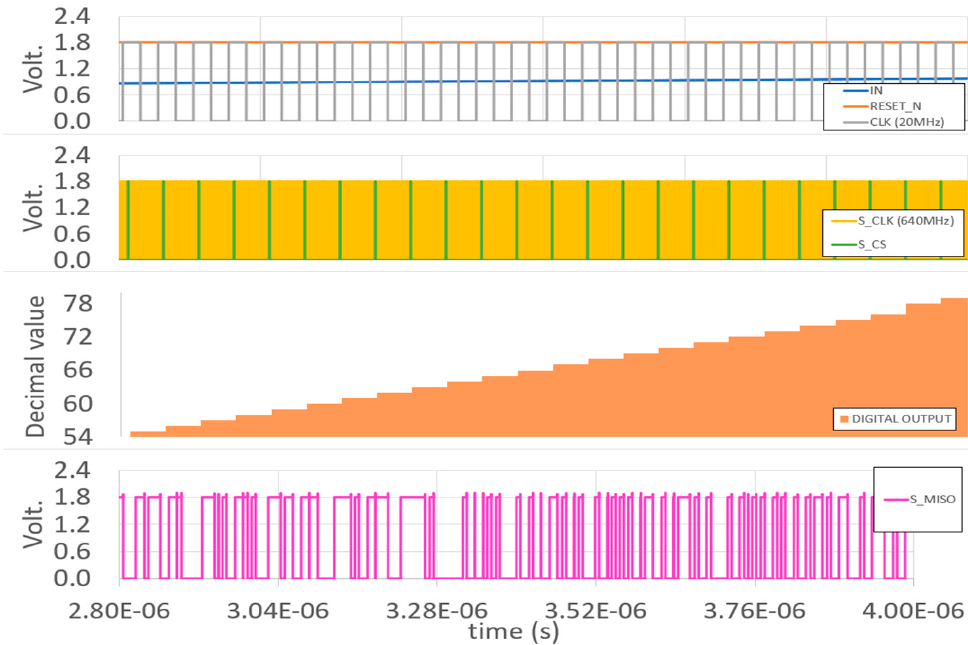
Figure 17. Full design post-layout simulation with output from 56 to 76.